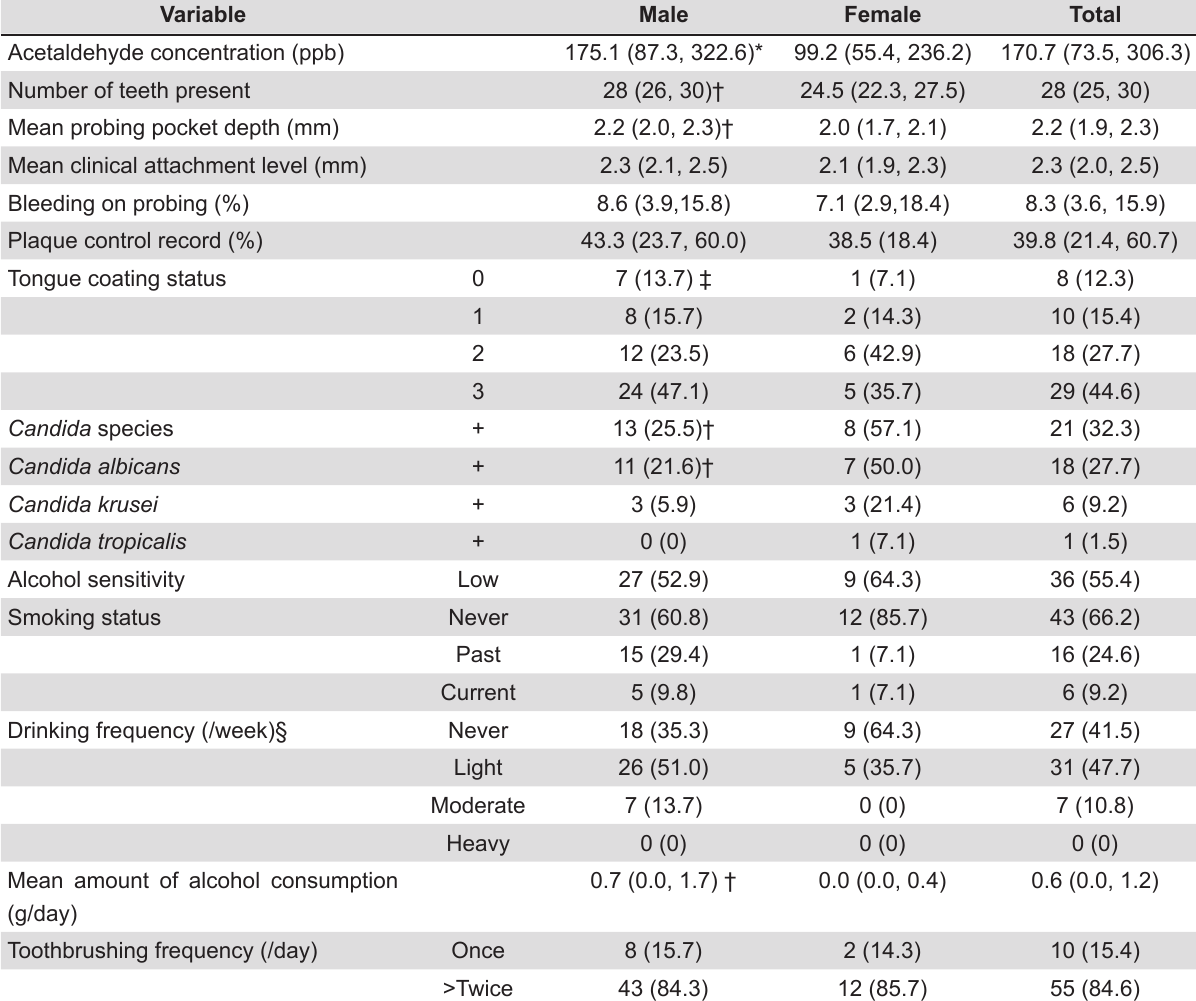
Table 1- Characteristics of participants